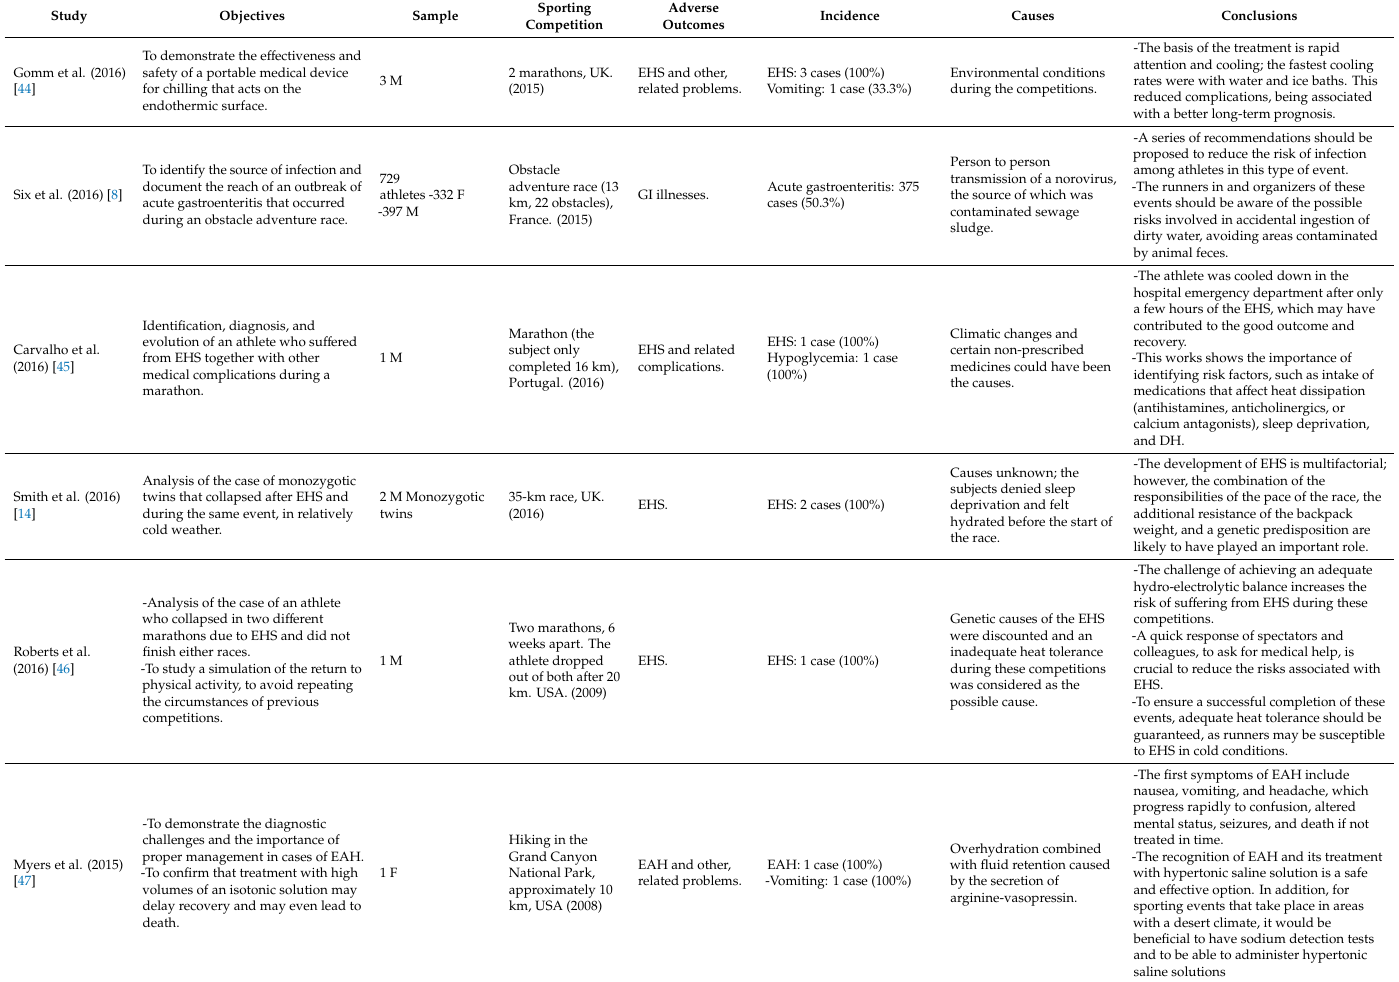
Table 3. Nutrition-related adverse outcomes in competitions and endurance and ultra-endurance sports, investigated in case studies. Study Objectives Sample Sporting Competition Adverse Outcomes Incidence Causes